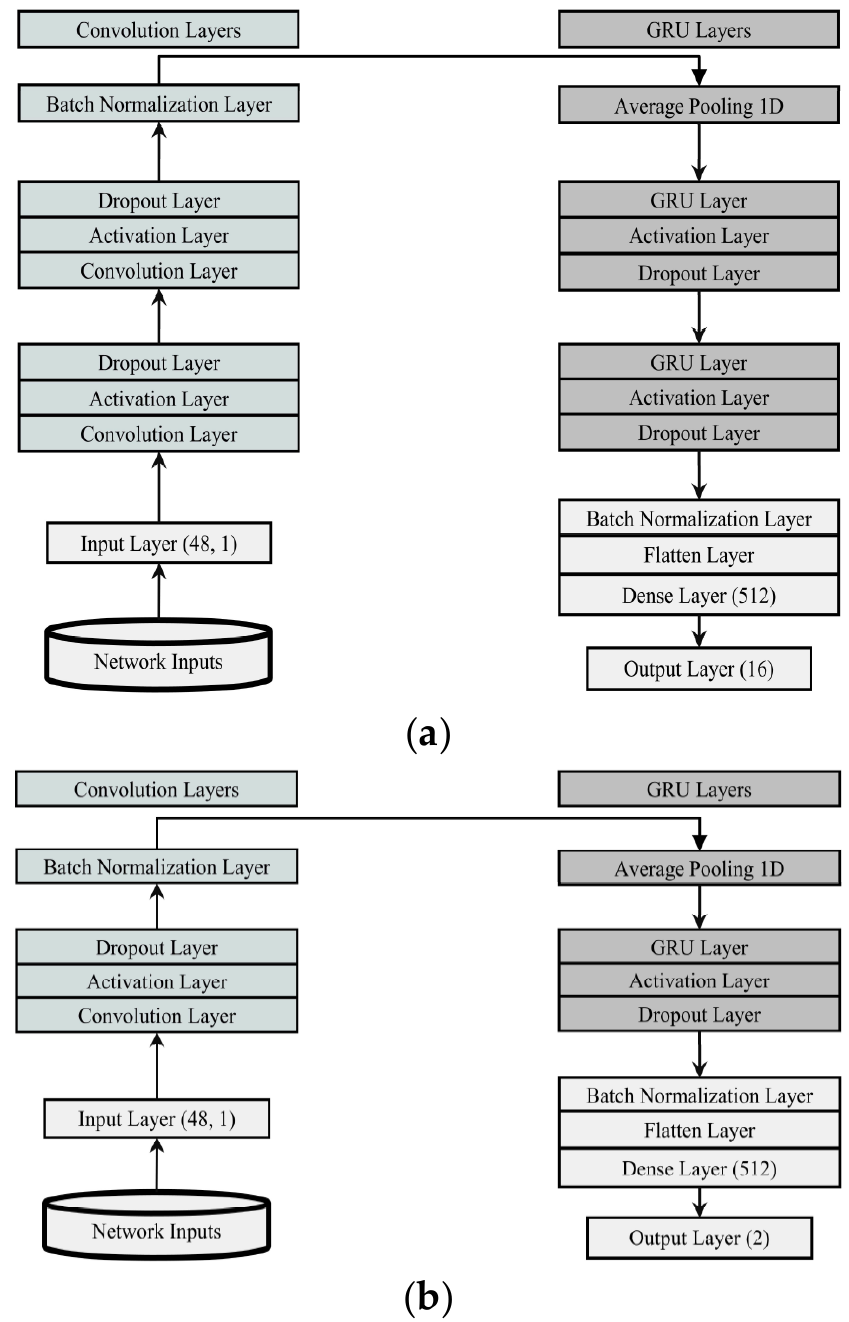
Figure 1. ( a ) Multiclass CNNGRU model. ( b ) Binary CNNGRU model.